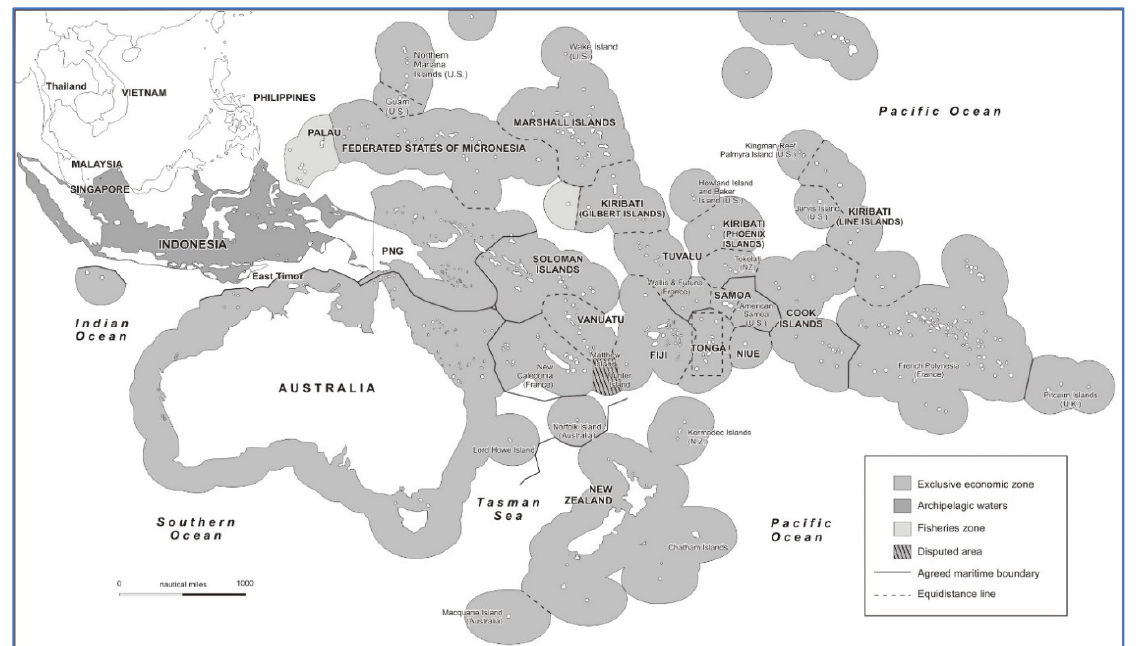
Figure 1. Pacific maritime limits and boundaries.